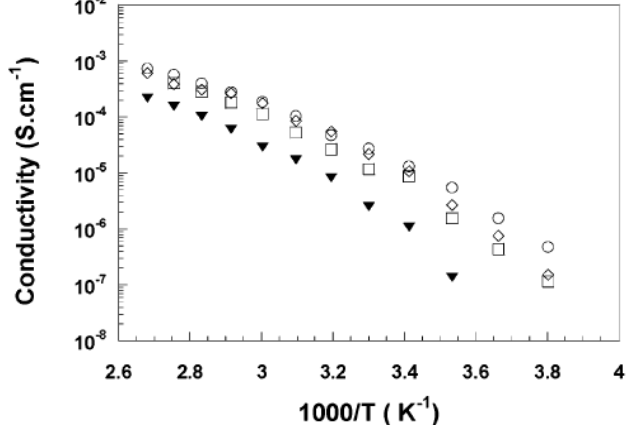
Figure 6. Arrhenius plot of the ionic conductivity for composite NPC400-LiTFSI (O/Li = 12) electrolytes cross-linked with 2 wt% HPPK and filled with 0 (  ); 6 (  ), and 10 wt% (  ) of tunicin whiskers and unfilled NP400-LiTFSI (O/Li = 12) electrolyte cross linked with 10% HPPK (▼)